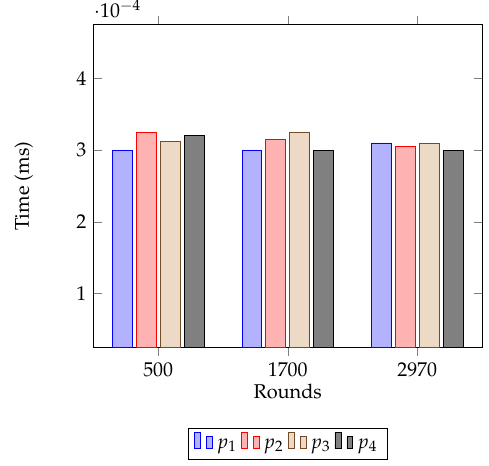
Figure 9. Average energy consumption in each cluster with the proposed approach at Rounds 500, 1700 and